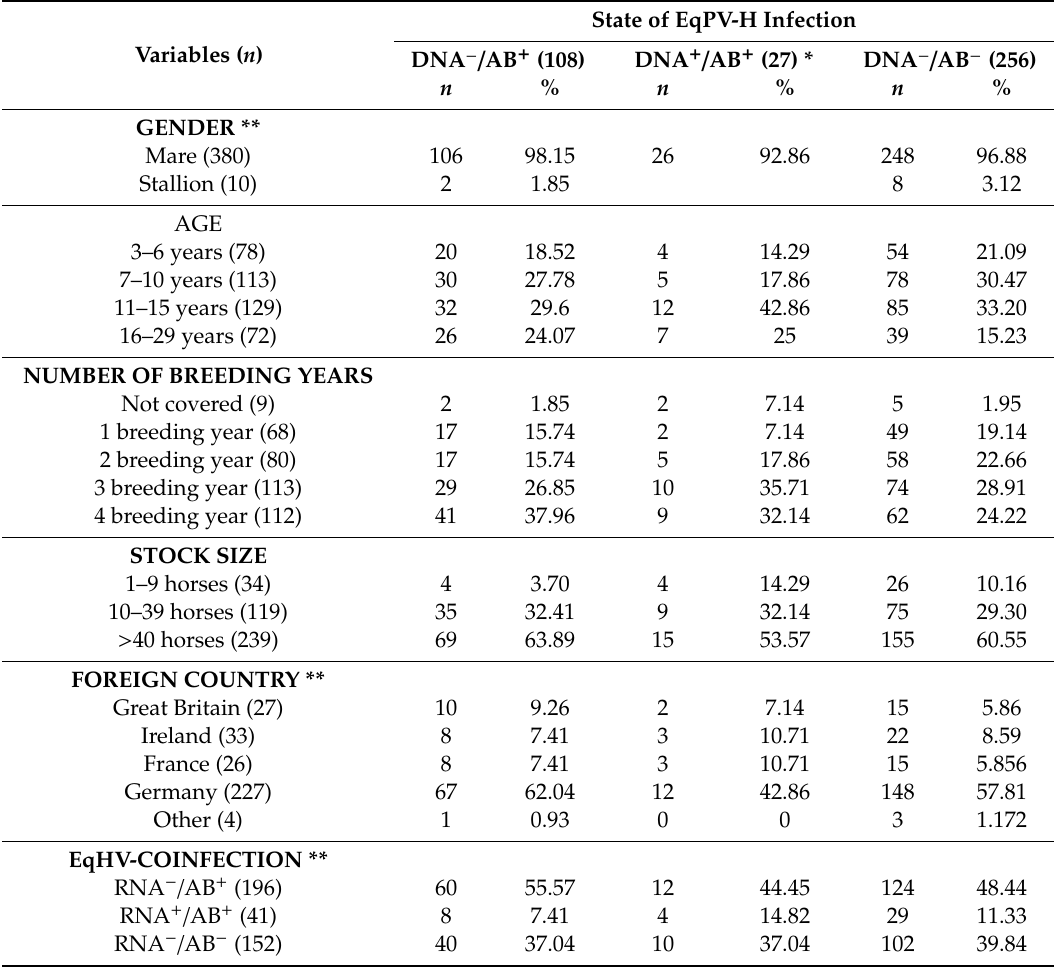
Table 1. General information regarding gender, age, breeding history, stock size, travel background, and EqHV-coinfectionoftheequineserumsamplescollectedfromThoroughbredsinNorthRhine-Westphalia and Lower